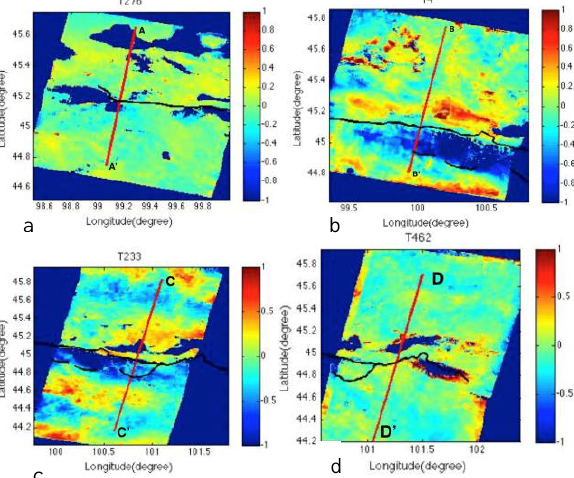
Figure 5. Postseismic interferogram rate maps on four tracks shows separately. Colour scale is line-of-sight velocity in cm/yr. Black line shows 18-segment fault trace modified from fieldwork (Kurushin et al., 1997). Red line A-A’, B-B’, C-C’, D-D’ denote locations of displacement profiles shown in Figure 7 a,b,c,d, a’,b’,c’,d’, and also show the elevation plot at the right side y axis. Positive range change refers to movement away from the satellite, negative range change refers to movement toward the